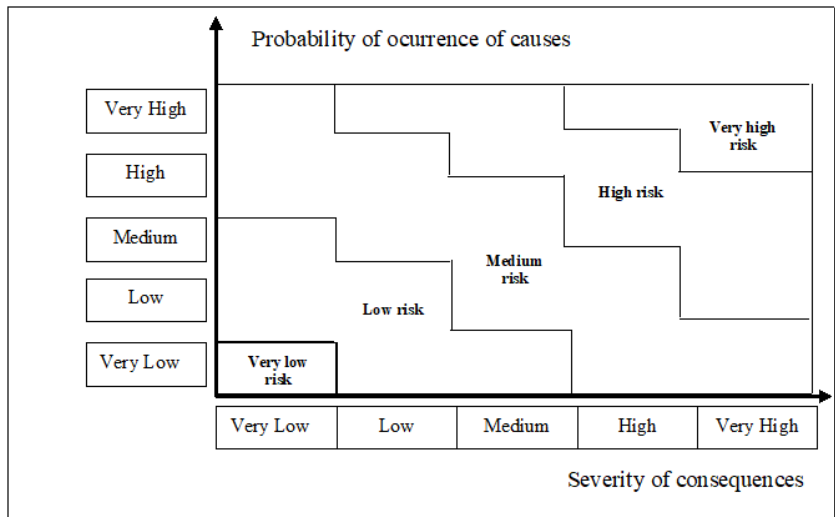
Figure 7. A 5 × 5 risk matrix for cybersecurity in telemedicine.